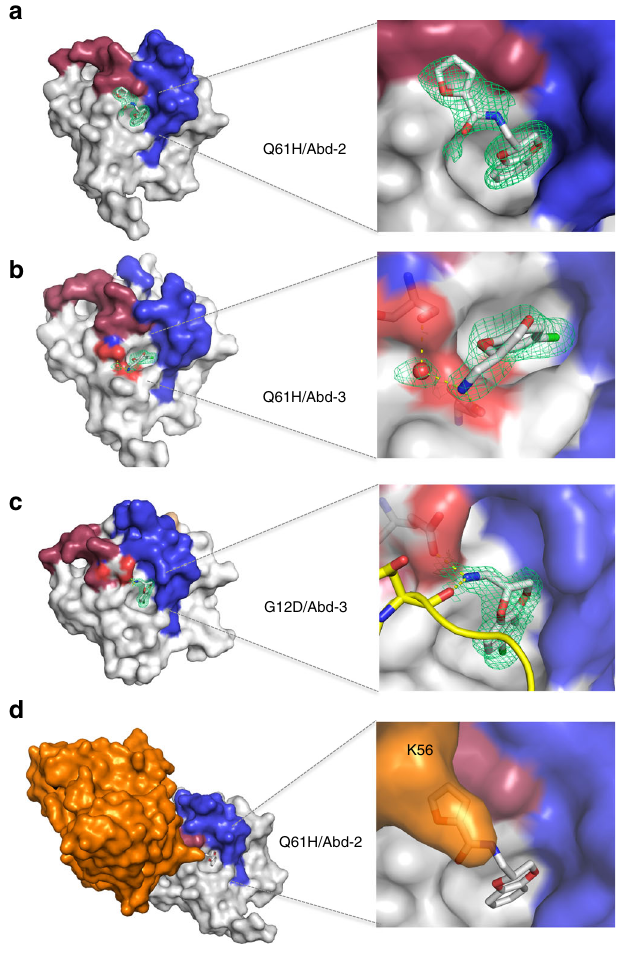
Fig. 2 Crystal analysis shows how compounds bind and VH competition results. KRAS Q61H or KRAS G12D protein crystals were soaked with compounds, and X-ray diffraction data were collected for determining the binding modes of the compounds. a KRAS Q61H -GppNHp soaked with Abd-2. The expanded view of the binding region of this compound (right hand panel) shows clear electron density ( 2mFo-DFc maps contoured at 1.0 r.m.s. green) attributed to the benzodioxane and furanyl amide parts of the compound. b , c Crystal structures and electron densities for Abd-3 soaked into KRAS Q61H -GppNHp or KRAS G12D -GppNHp, respectively. The chlorine atom in Abd-3 is depicted in green. The Abd-3 – KRAS interactions differ in two mutants, but the H-bond to a neighbouring molecule in the crystal lattice for G12D means that the Q61H complex is unencumbered by the crystal contacts ( b ). The switch I/II regions are coloured in red and blue, respectively, are de fi ned here as 30 – 38 (switch I) and 60 – 76 (switch II). d Explanation for the competition of compound Abd-2 binding to RAS by steric hindrance. The left-hand panel shows a surface representation of mutant HRAS G12V -GppNHp (light blue) and the anti-RAS VH from the Fv depicted in orange. The left-hand panel is the surface representation is the KRAS Q61H -GppNHp structure soaked with Abd-2, with anti-RAS VH superimposed on KRAS Q61H -GppNHp. The expanded right-hand representation shows the predicted steric hindrance between VH and the compound, in particular VH CDR2 residue K56 (transparent, orange representation). Although the K56 side chain is fl exible, it is prevented from rotating away from the clash with Abd-2 by steric hindrance with neighbouring regions of